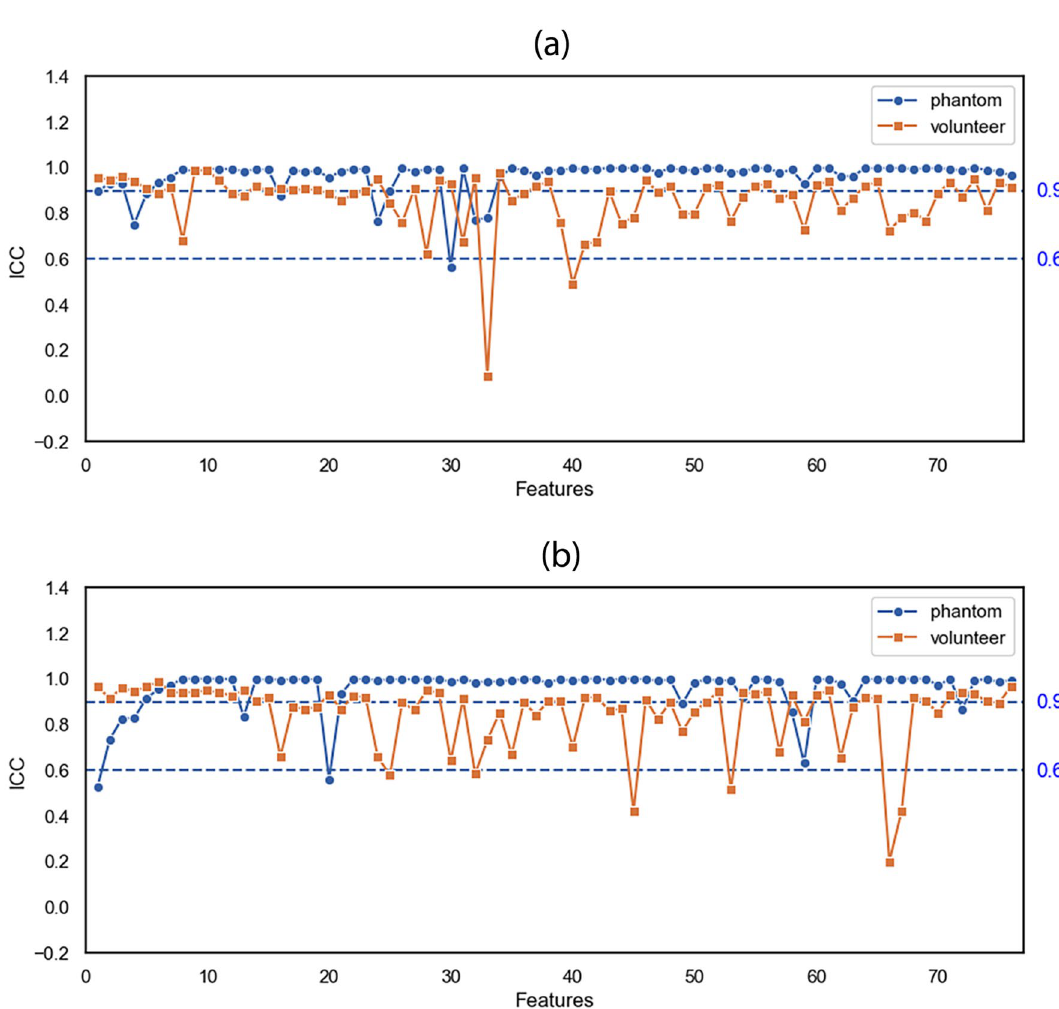
Figure 3. ICC plots in ( a ) T1-weighted and ( b ) T2-weighted images of the phantom and volunteer. The blue circles and orange squares represent the ICC values for the phantom and volunteer, respectively. The order of the features’ names is shown in Table